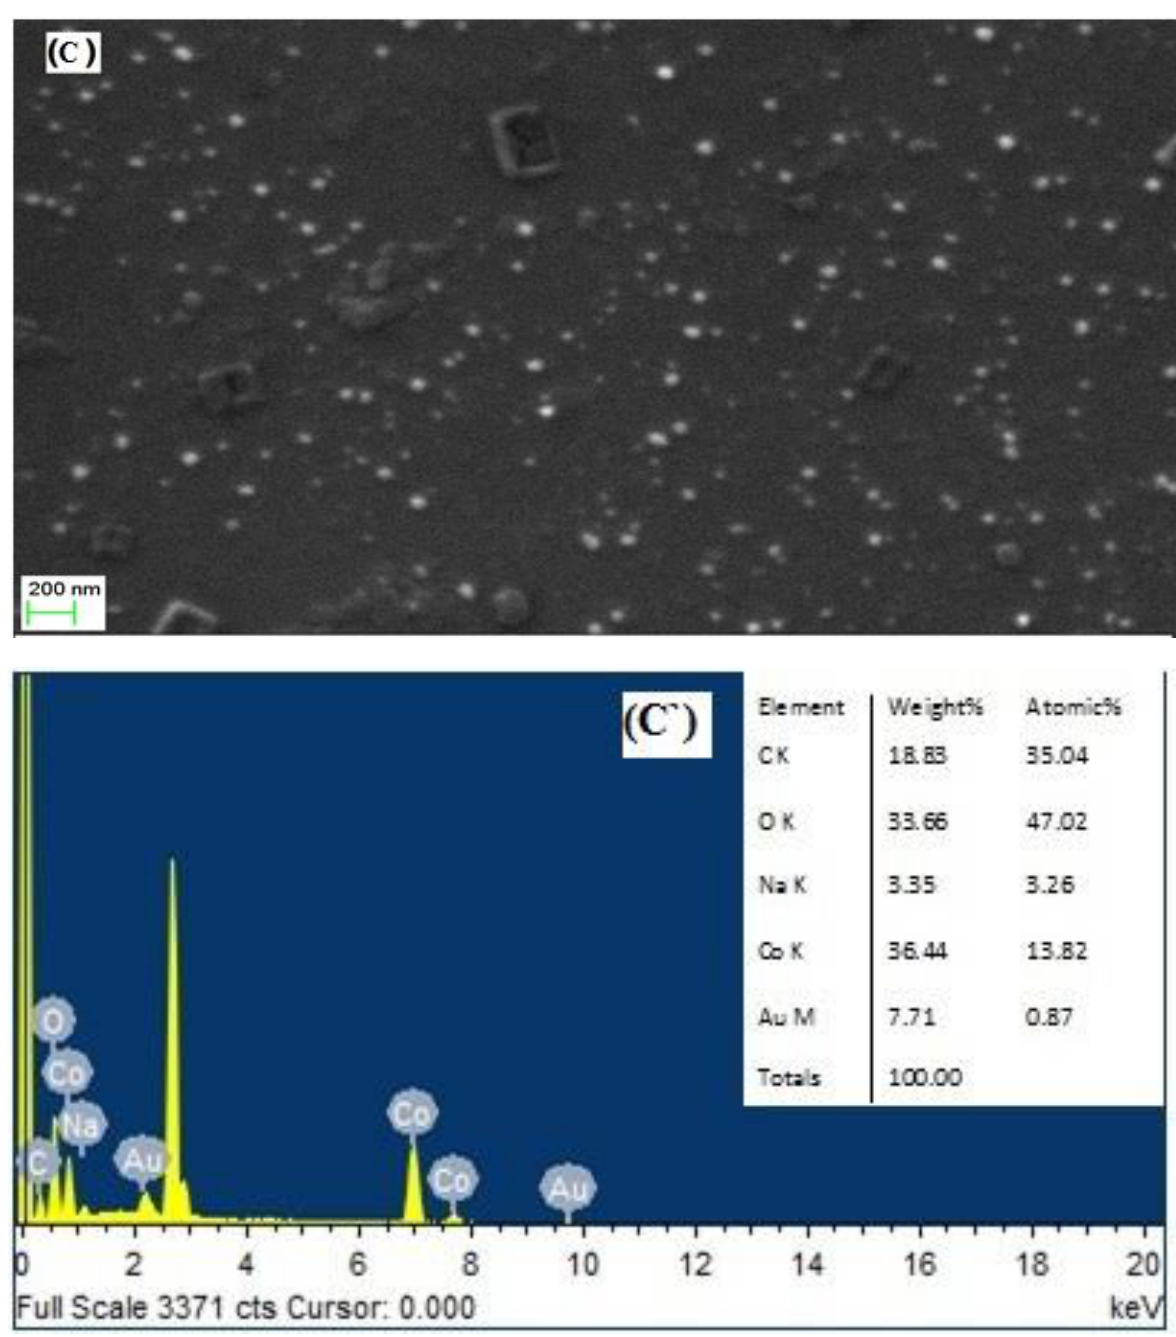
Figure 4. SEM ( A – C ) and EDX ( A` – C` ) micrograph of Mn – alginate, Fe – alginate, Co – alginate nano-